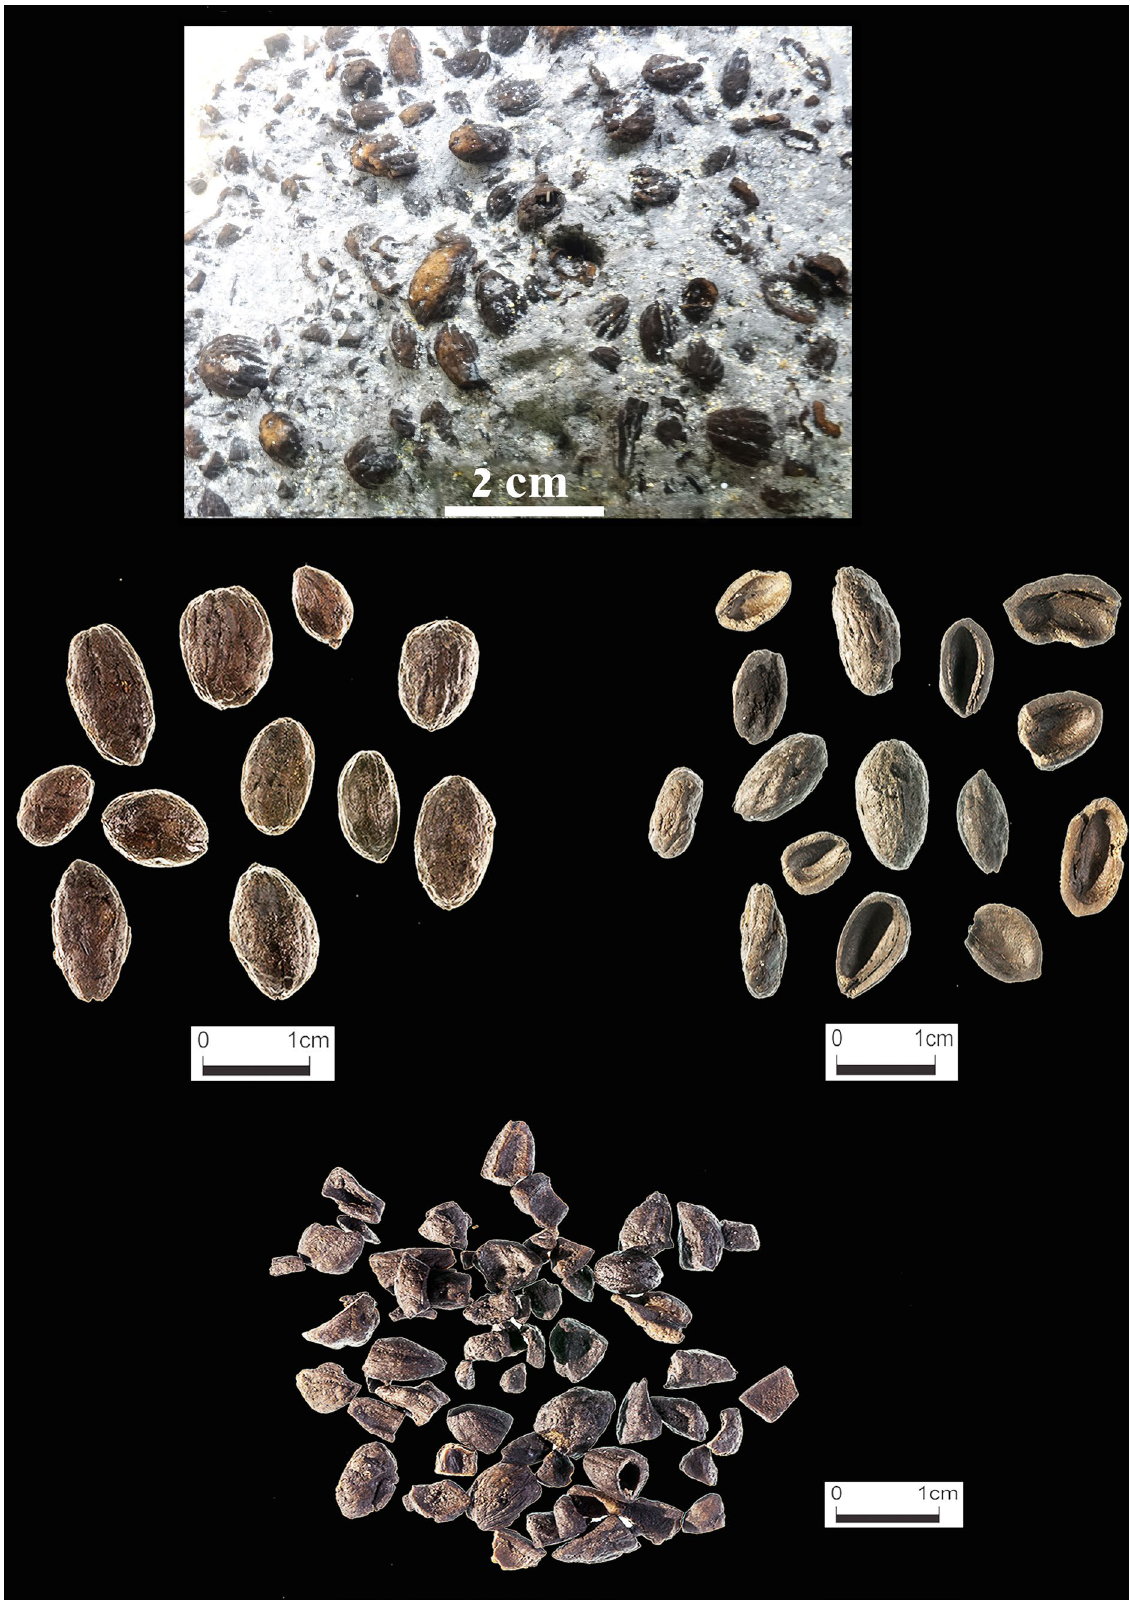
Figure 5. Olive pits from Hishuley Carmel: as found inside the Structures (top); whole (center left); whole and halves (center right); fragments (bottom) (Photos: Ehud Galili-top photo, Sasha Flit-center and